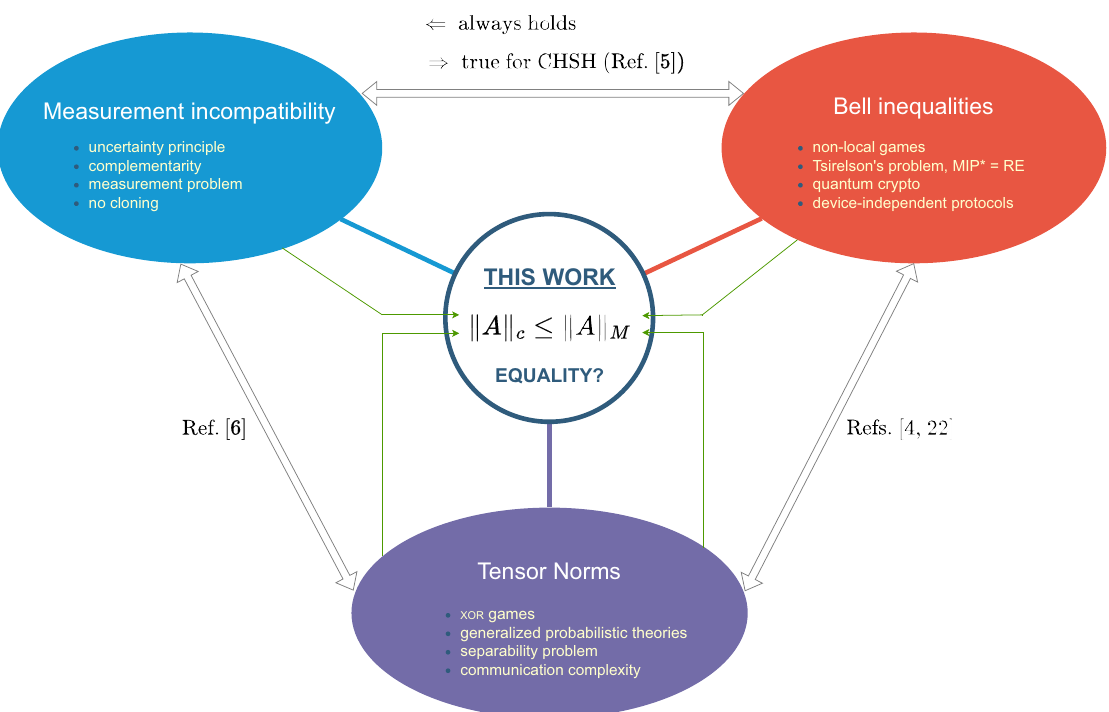
FIG. 1. In this work, we relate measurement incompatibility with Bell inequalities using the formalism of tensor norms. Pairwise connections having already been established in the literature, we bring the three concepts together for the first